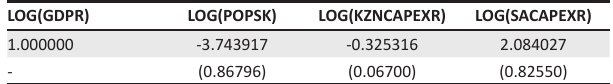
TABLE 2: Normalised co-integrating coefficients (standard error in parentheses).